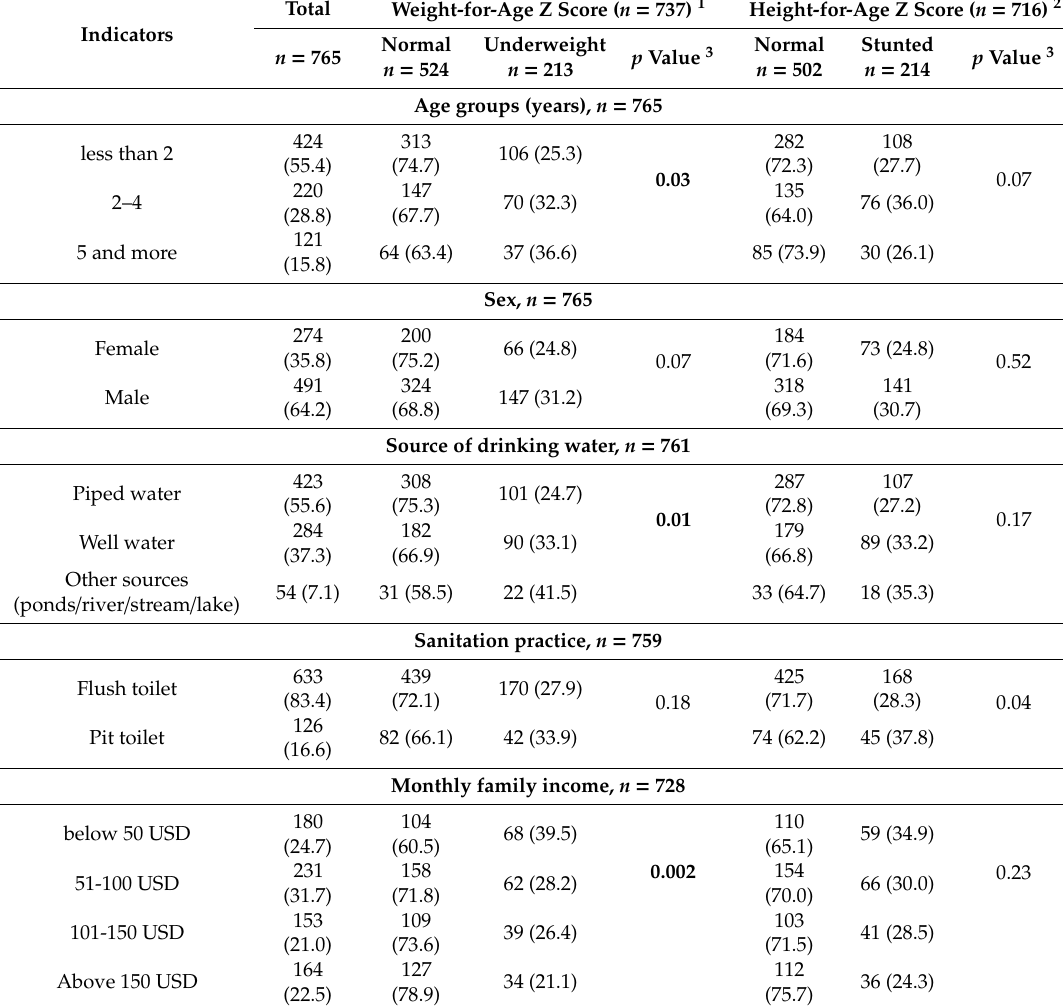
Table 2. Socio-demographic characteristics of children and their nutritional